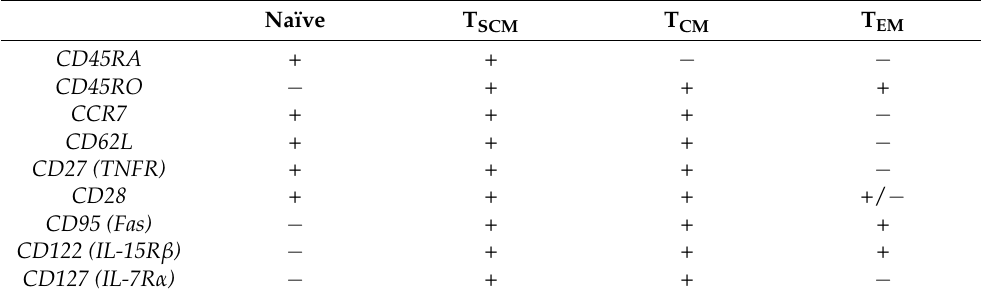
Table 1. Cell surface markers of the different memory CD8 + T cell subsets